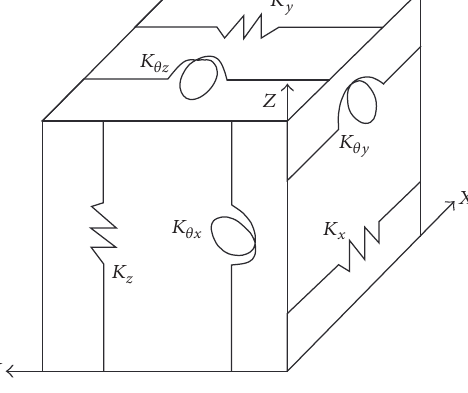
Figure 12: Spring